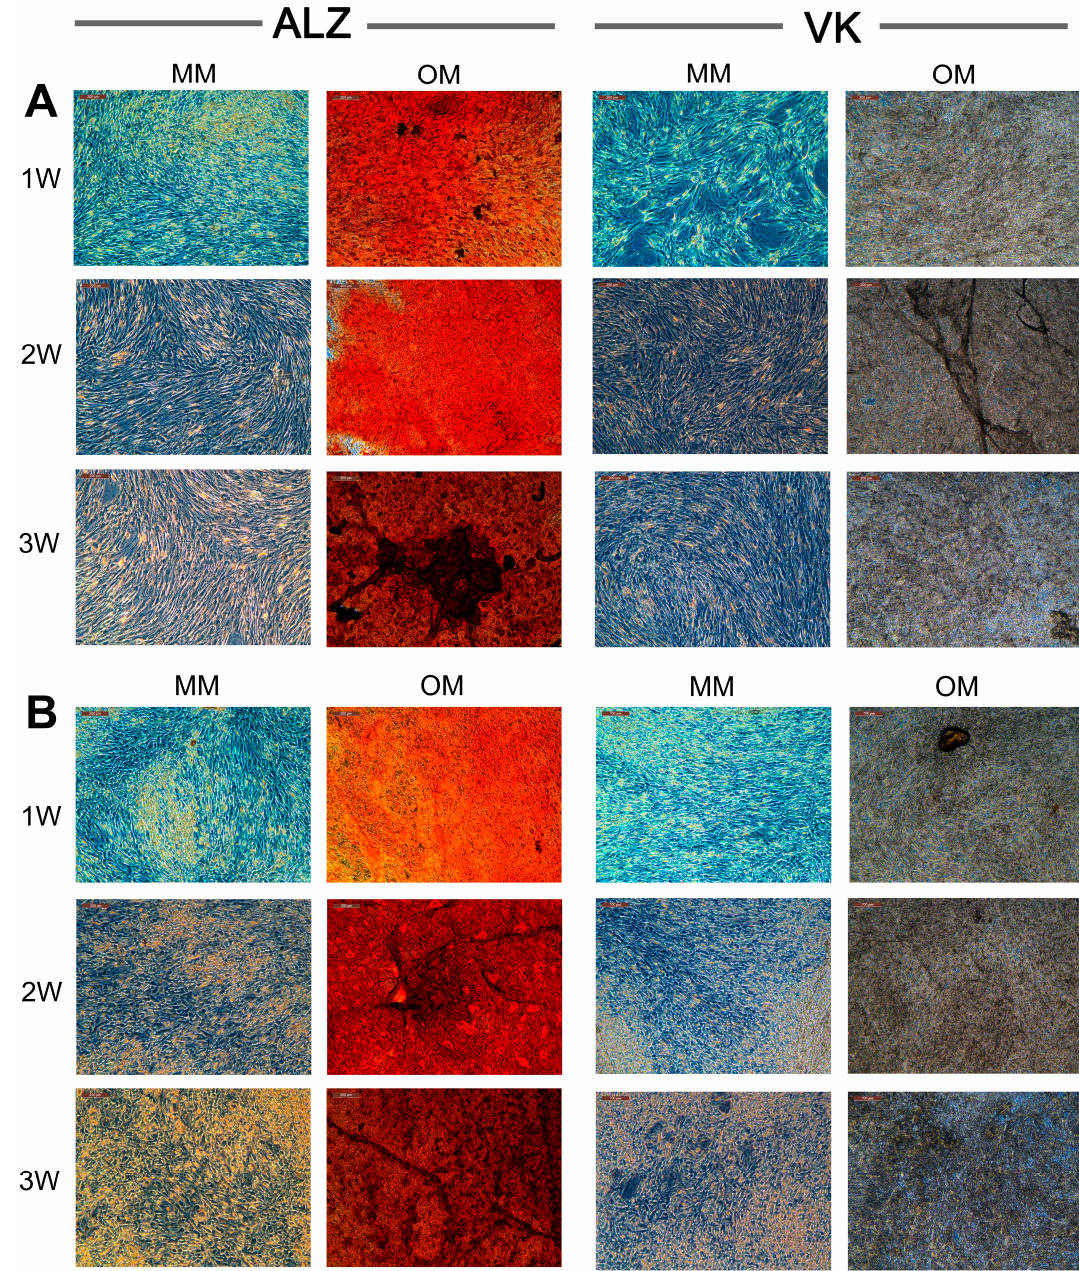
Figure 3. Representative photomicrographs of ( A ) hBM-MSC and ( B ) hAT-MSC grown in maintenance medium(MM)ortreatedwithosteogenicmedium(OM)toinduceextracellularmatrixbiomineralization, detected using Alizarin Red S (ALZ) or Von Kossa (VK) stains at 1-, 2- and 3-week time